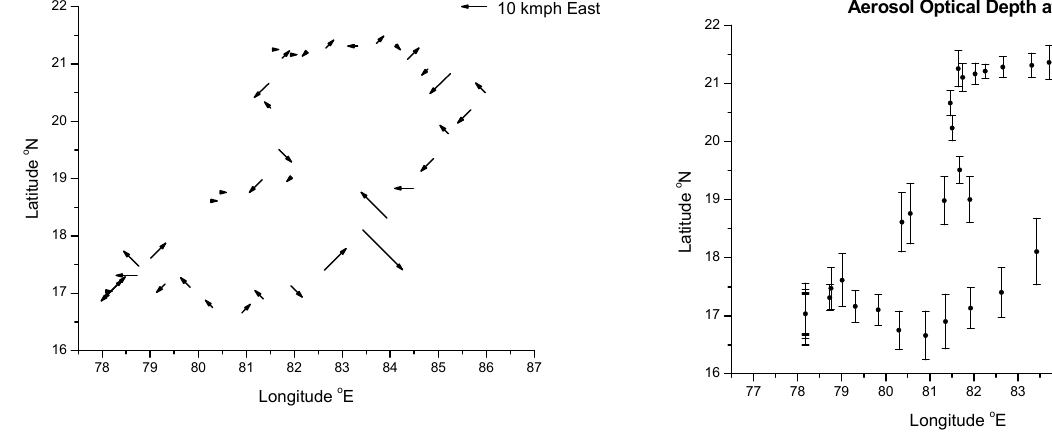
870nm (bottom panel at different locations). The points represent the coordinates of the observations sites and the length of the verti- cal bar represents the magnitude of